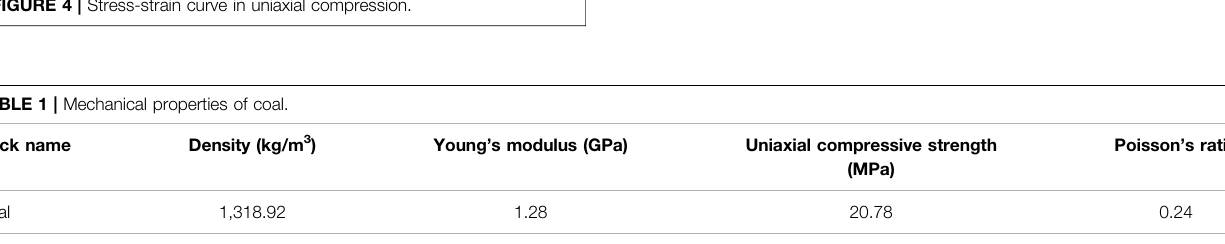
FIGURE 4 | Stress-strain curve in uniaxial compression.